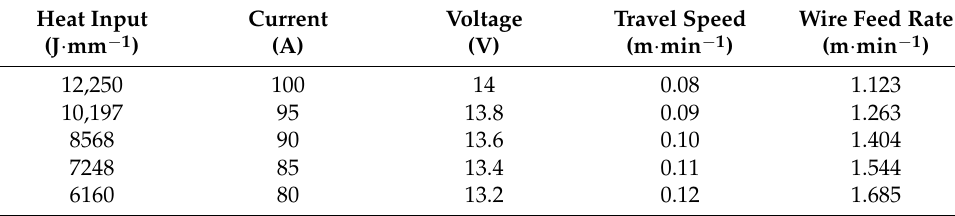
Table 2. Process parameters during WAAM under different heat input.